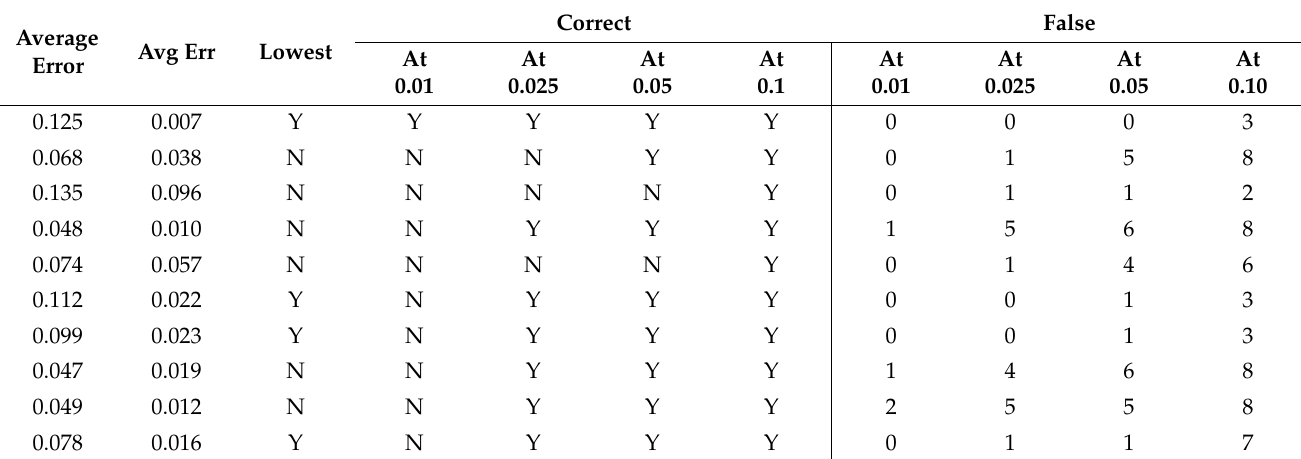
Table A229. Set 3, trials 41–50 summary data (actual PR value).